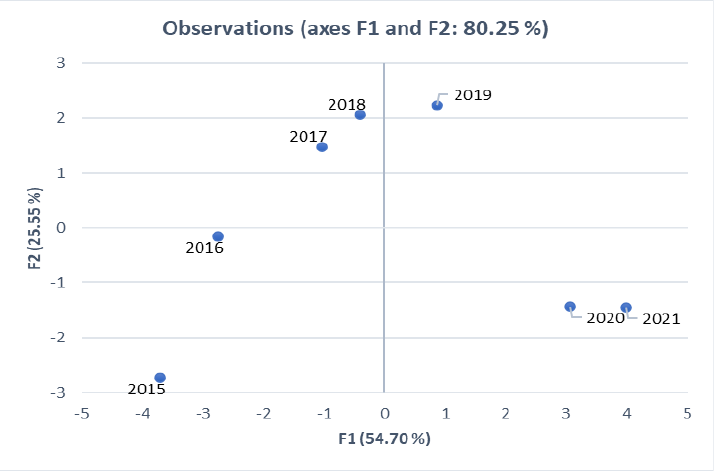
Figure 6. Representation of the years analyzed in the system of the first two factorial